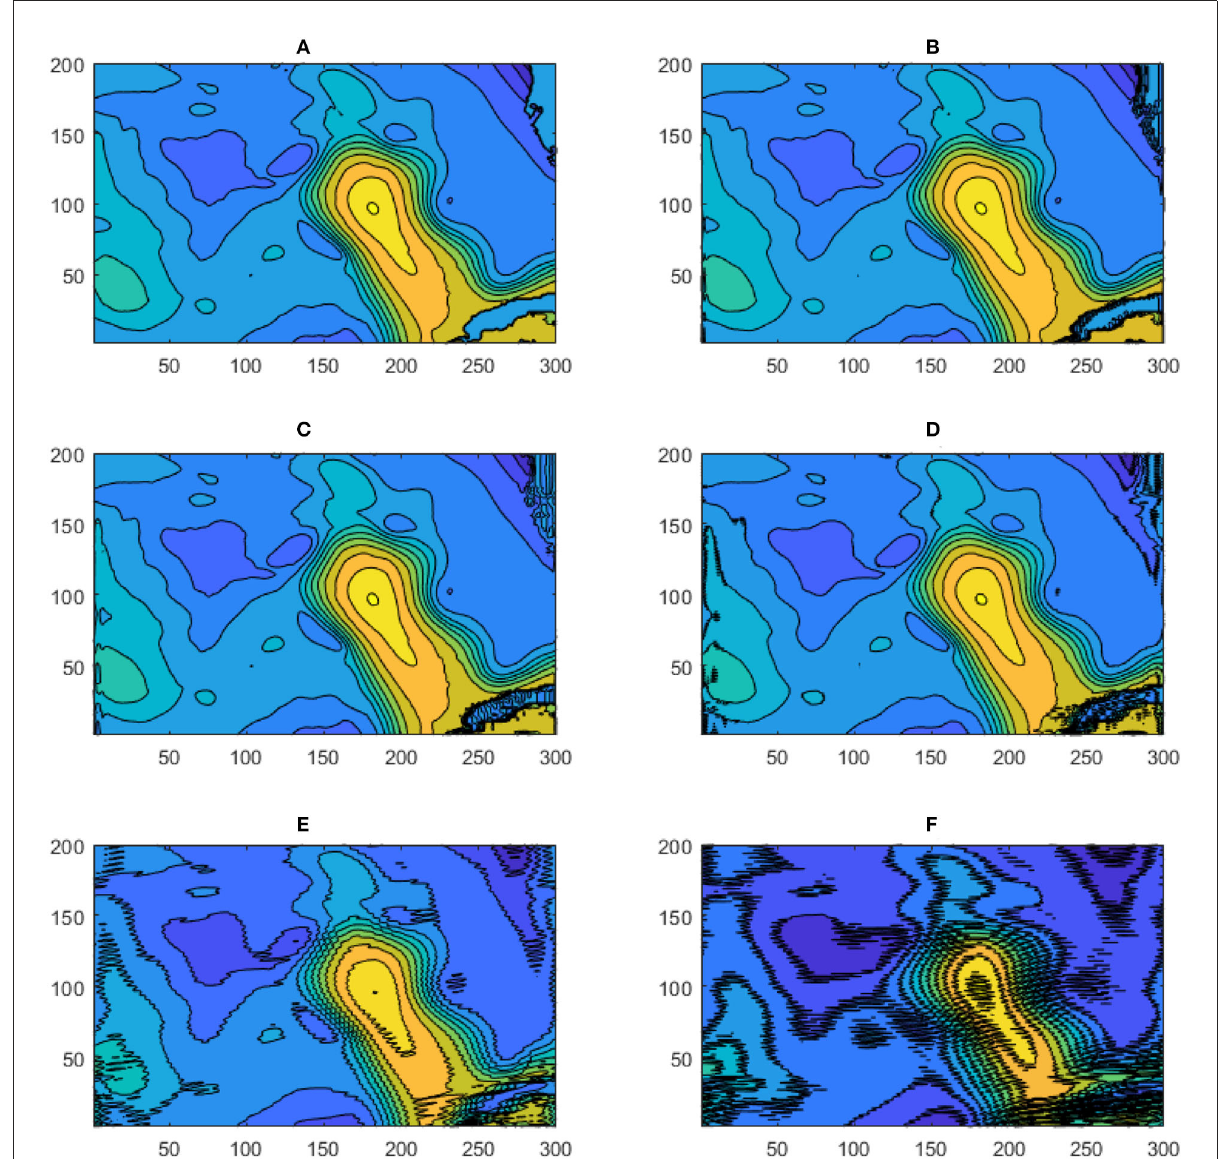
FIGURE7 Reconstructed SSH for five DWT compression levels. (A) Observed SSH; (B) SSH reconstructed from the level 1 DWT compression; (C) SSH reconstructed from the level 2 DWT compression; (D) SSH reconstructed from the level 3 DWT compression; (E) SSH reconstructed from